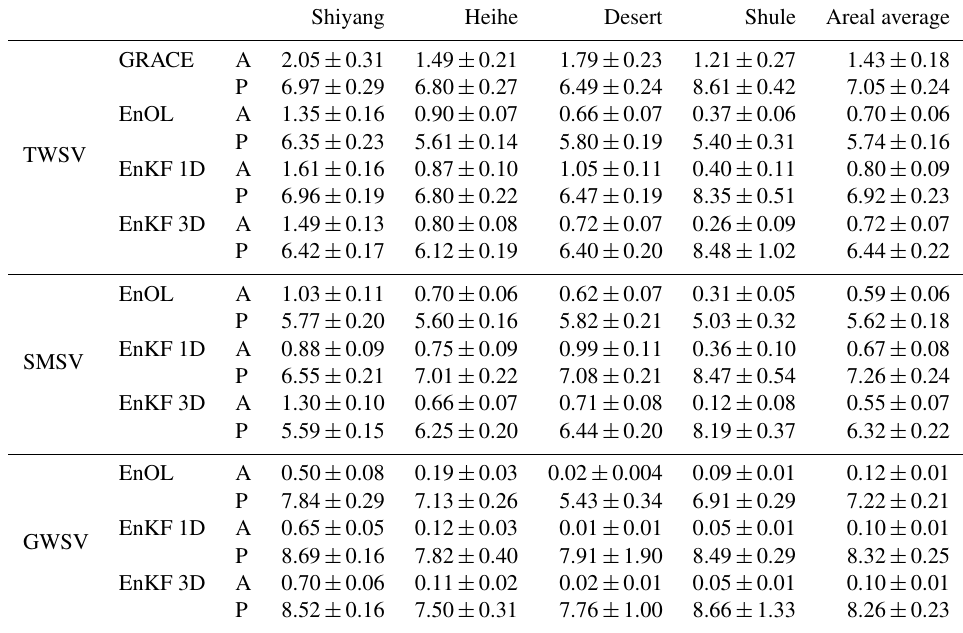
Table 2. TWSV, SMSV, and GWSV estimated annual amplitude (A, cm) and phase (P, month) in four different basins computed between April 2002 and December 2010. Areally averaged values for the entire Hexi Corridor are also